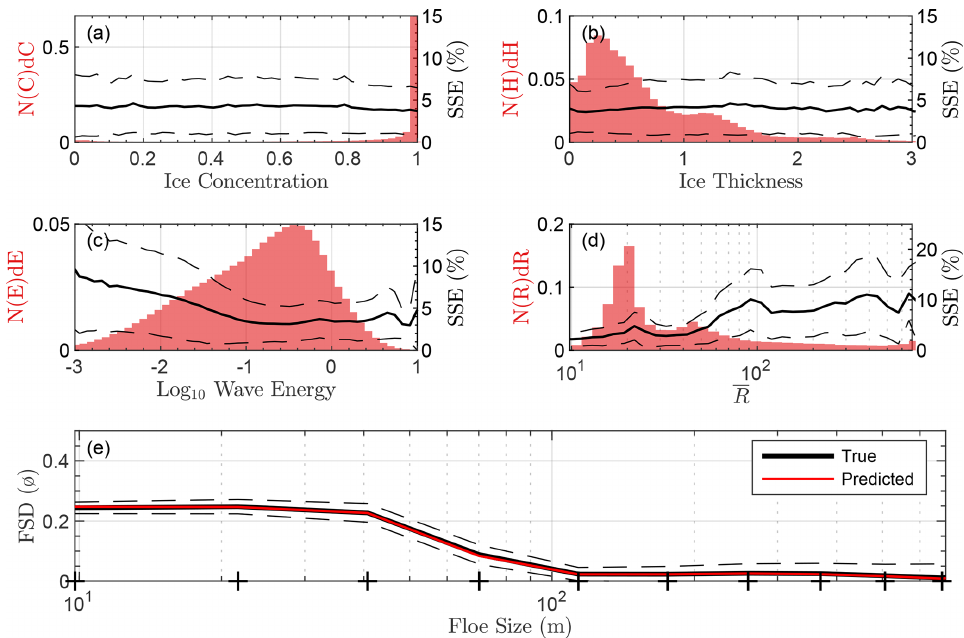
Figure 2. Performance of NN-WIFF on validation data. Histogram ( a , left axis) of sea ice concentration, C , in the validation dataset. Median ( a , right axis) standardized size error (SSE, Eq. 9) as a function of C (solid line). Dashed lines are the interquartile distance of SSE. (b– d) Same as (a) , but for (b) sea ice thickness, (c) log 10 wave energy, and (d) representative radius ( R , Eq. 8) of the “true” output histogram. (e) Mean histogram output A i d r i for (black) the validation dataset and (red) parameterization output ˆ F i d r i . Dashed lines are the standard deviation of error between A i d r i and ˆ A i d r i in each floe size category. Crosses indicate floe size bin centers.